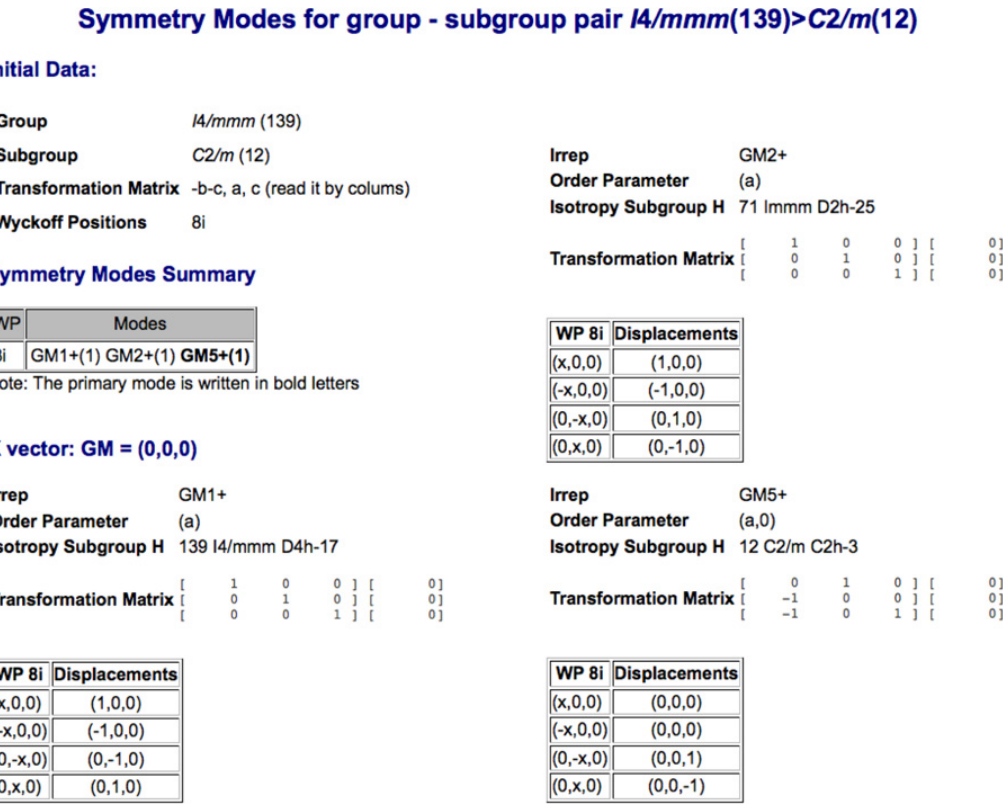
Figure 6. Output of SYMMODES for the pair I 4 /mmm −→ C 2 /m ( − b − c , a , c ; 000) and the Wyckoff positions 8 i